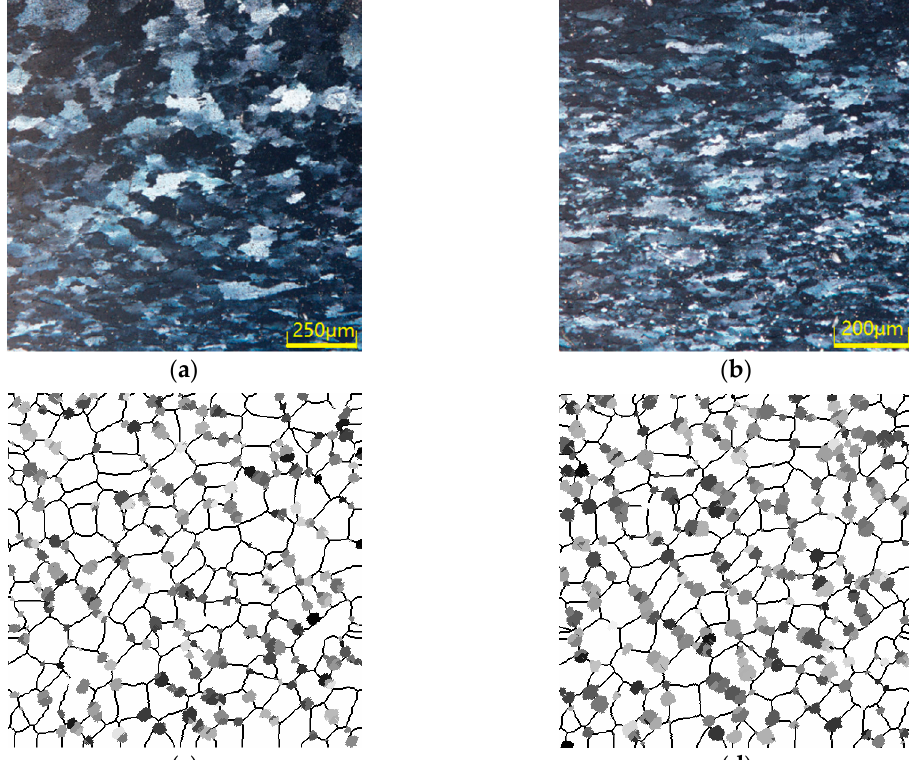
( e ) Figure 8. The experimental ( a , b ) and CA ( c , d ) results for microstructures formed at deformation temperatures of 350 C  ( a , c ) and 450 C  ( b , d ); ( e ) the variation of the recrystallized volume fraction and the mean grain size at temperatures of 350 C  and 450 C  . 4.3. Strain Rate Effect The simulation results for microstructures formed at various strain rates and a constant deformation temperature (450 C  ), constant strain (0.35), and constant delay time (60 s) are shown in Figure 9. The results show that the recrystallized volume fraction increases with increasing strain rate and yields 80.07% at 0.1 s − 1 and 86.06% at 1 s − 1 . However, the average grain size is slightly reduced with increasing strain rate and is 62.50 μ m at 0.1 s − 1 and 45.45 μ m at 1 s − 1 . During the hot deformation test, the dislocation density increases rapidly with an increasing strain rate, and a great quantity of deformation energy for recrystallization nucleation and grain growth is generated, which increases the recrystallized volume fraction. However, too much nucleation inhibits the growth of grains, and as a result, the average grain size decreases slightly. Therefore, improving the strain rate is propitious for increasing the volume fraction and size of recrystallized grains.